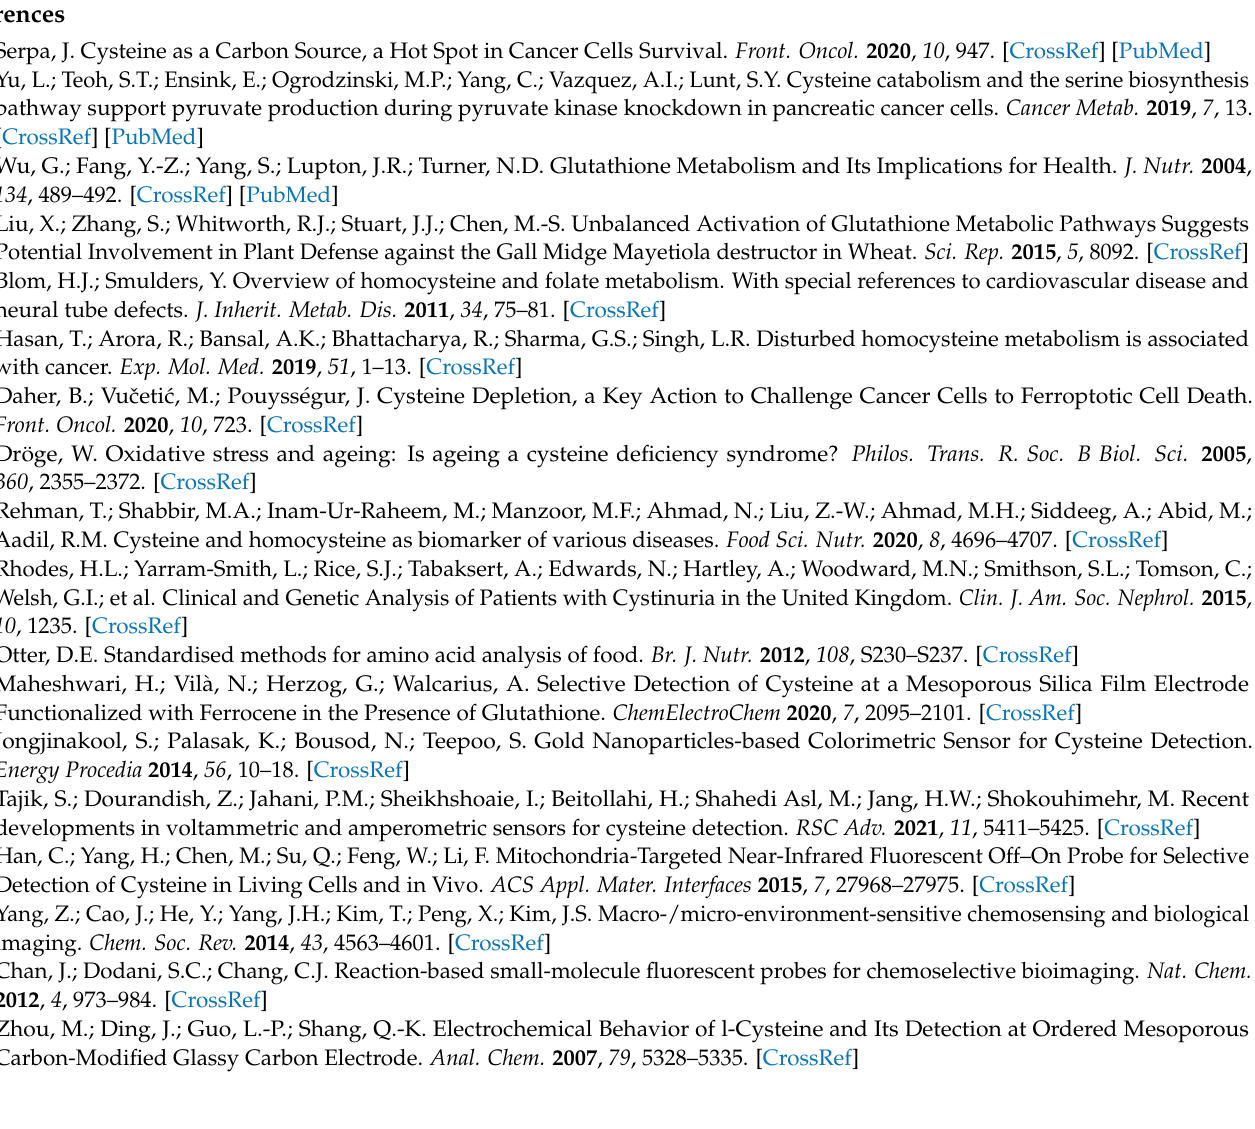
λ em = 455 nm), Figure S10: Mass spectra of a reaction product obtained by reacting equimolar ABIA and Cys for 60 min at 25 ◦ C, Table S1: 1 H NMR and 13 C NMR chemical shifts ( δ ppm) of the ABIA tautomer’s A and B, Table S1. 1 H NMR and 13 C NMR chemical shifts ( δ ppm) of the ABIA tautomer’s A and B; Table S2: Photophysical properties of compound 3 (10 µ M) in varying percentages of DMSO:0.01 M HEPES buffer solution, Table S3: A comparison of response time for cysteine detection by various methods, Table S4: A comparison of different probes used for cysteine